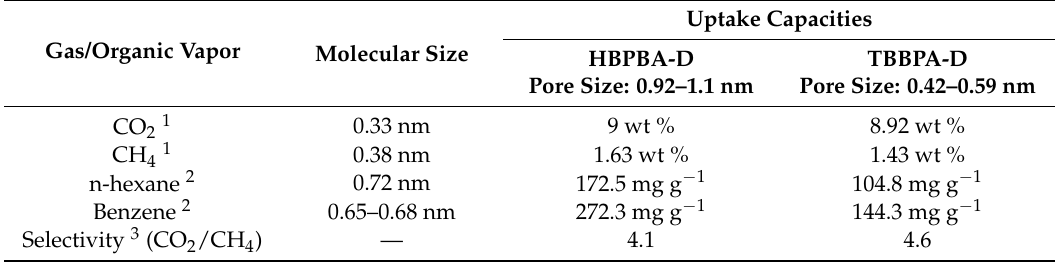
Table 2. Molecular size of gas/organic vapor and uptake capacities of HBPBA-D and